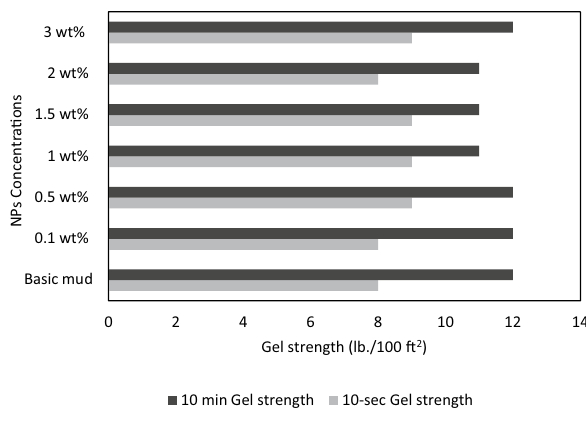
Fig. 9 API LTLP fluid loss at different NPs concentrations